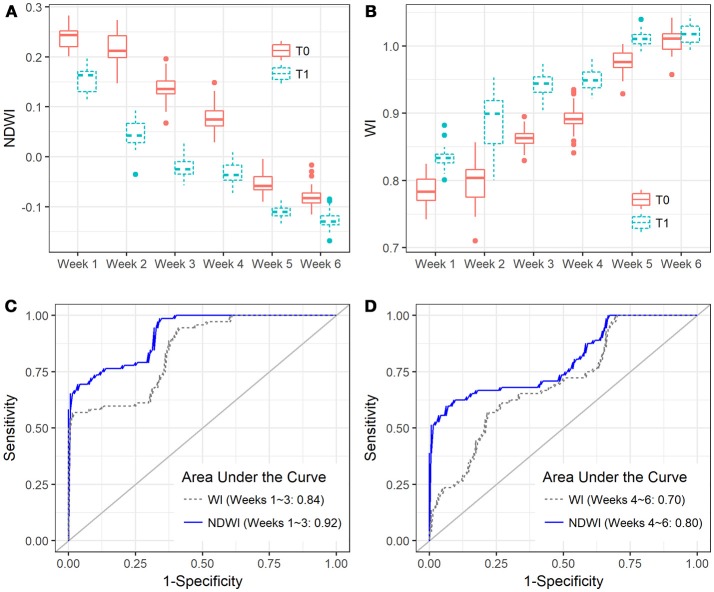
Boxplots show the capability of (A) NDWI and (B) WI in discriminating between the Zymoseptoria tritici un-treated (T0) and treated canopies (T1) of the four reference varieties (CH CLARO, DRIFTER, RUNAL, and TITLIS) in different sampling periods, and ROC plots show the comparison of NDWI and WI at the early (C, Weeks 1–3) and late (D, Weeks 4–6) periods.